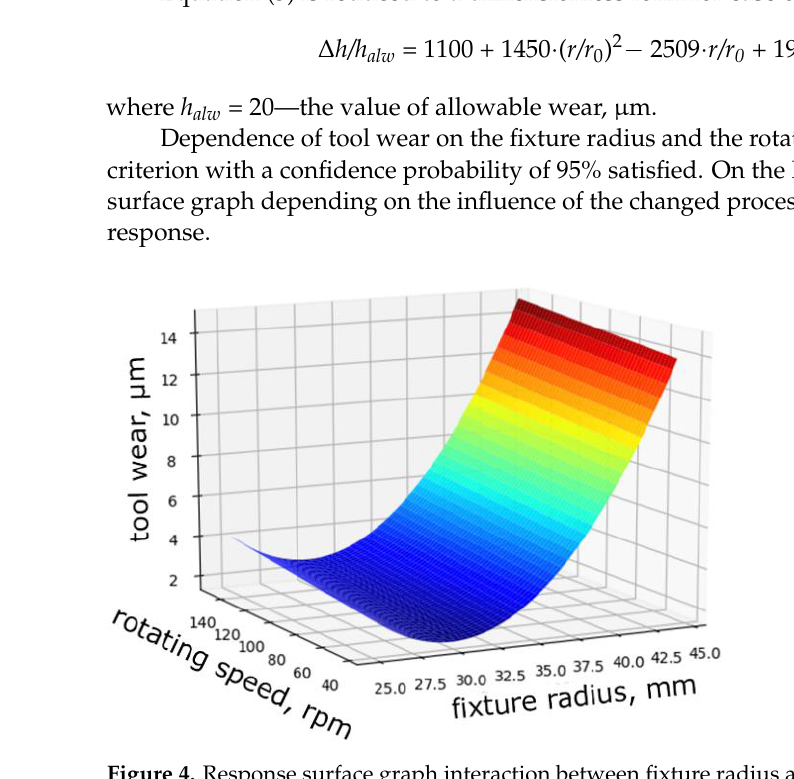
Figure 4. Response surface graph interaction between fixture radius and rotating speed. The minimal local tool wear was achieved when the workpieces are located in the fixture at the radius of r = 30 mm. However, it increases by 13 times when this value was increased to the maximum value of 44.5 mm (in this case, the diameter of the fixture covers half the diameter of the